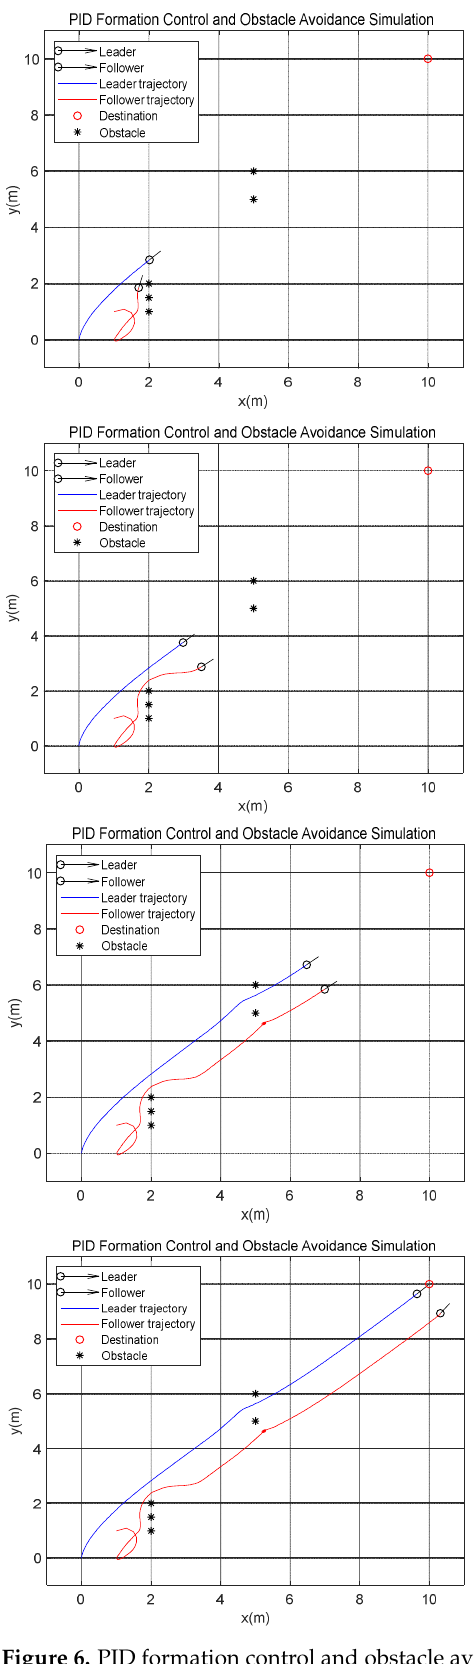
Figure 6. PID formation control and obstacle avoidance, with the following initialization: the initial position of the leader is (0, 0) and the initial position of the follower is (1, 1); the expected relative distance between the leader and the follower is (1, −1).